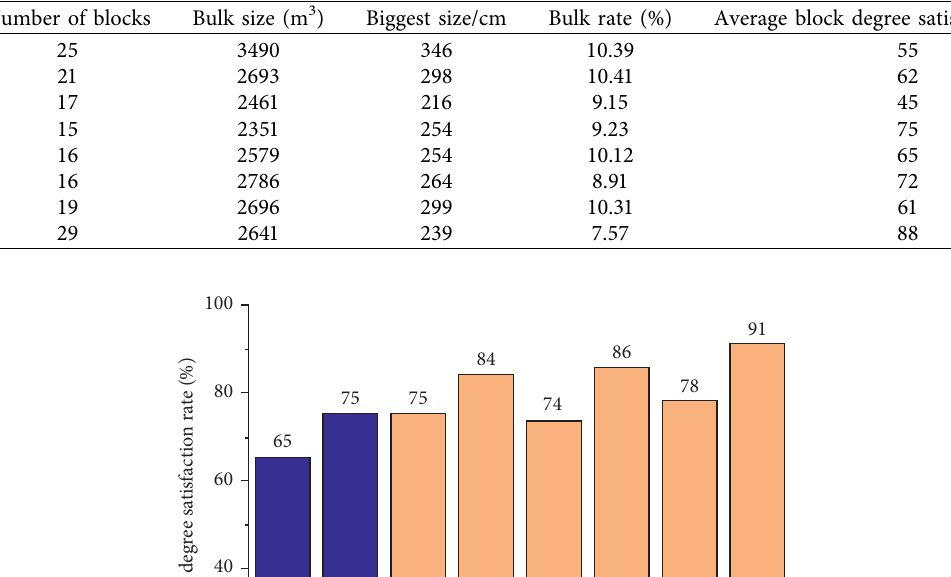
Table 5: Average lumpiness satisfaction rate statistical table.